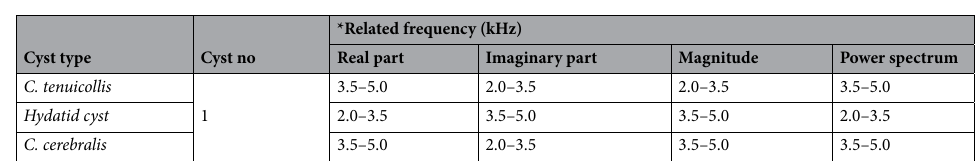
Table 3. Selectivity of the bio-analysis system. *Estimated based on direct interpretation of spectra shown in Fig. 6. The data ere interposed and reported based on at least two replicate analyses of the cyst by the recommended procedure under similar conditions. The data were reported based on both direct observations and evidenced by t-test at 95% confidence level.